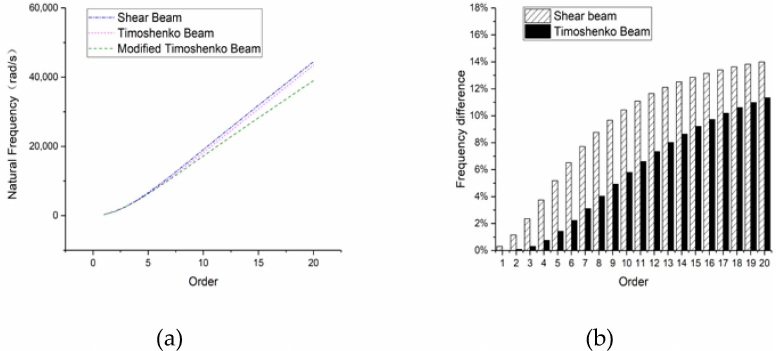
Figure 23. Natural frequencies of the 4-m-long beam: ( a ) overall frequency curve and ( b ) frequency di ff erence compared with a modified Timoshenko beam.